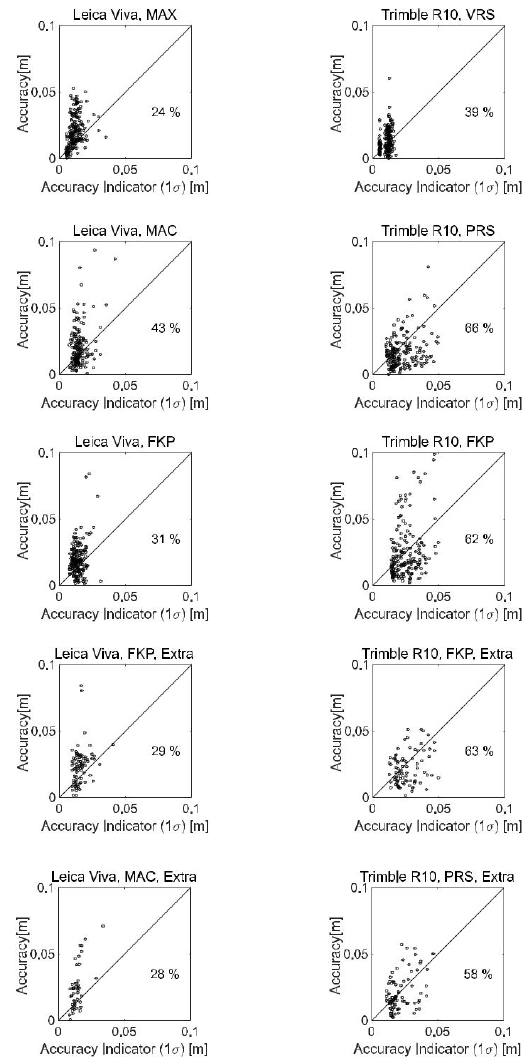
Figure 8: Horizontal rms (accuracy) vs quality indicator of the re- ceiver. Percentage number in the pictures tells percentage of the observations where quality indicator is larger than rms. Failed ini- tializations are removed from the datasets as well those observa- tions where the receiver gave worse than 10 cm plane accuracy. First row shows the results of commercial networks, next two rows refers to the NLS Positioning Service results in the interpolation measure- ments and last two rows include the results of the extrapolation network